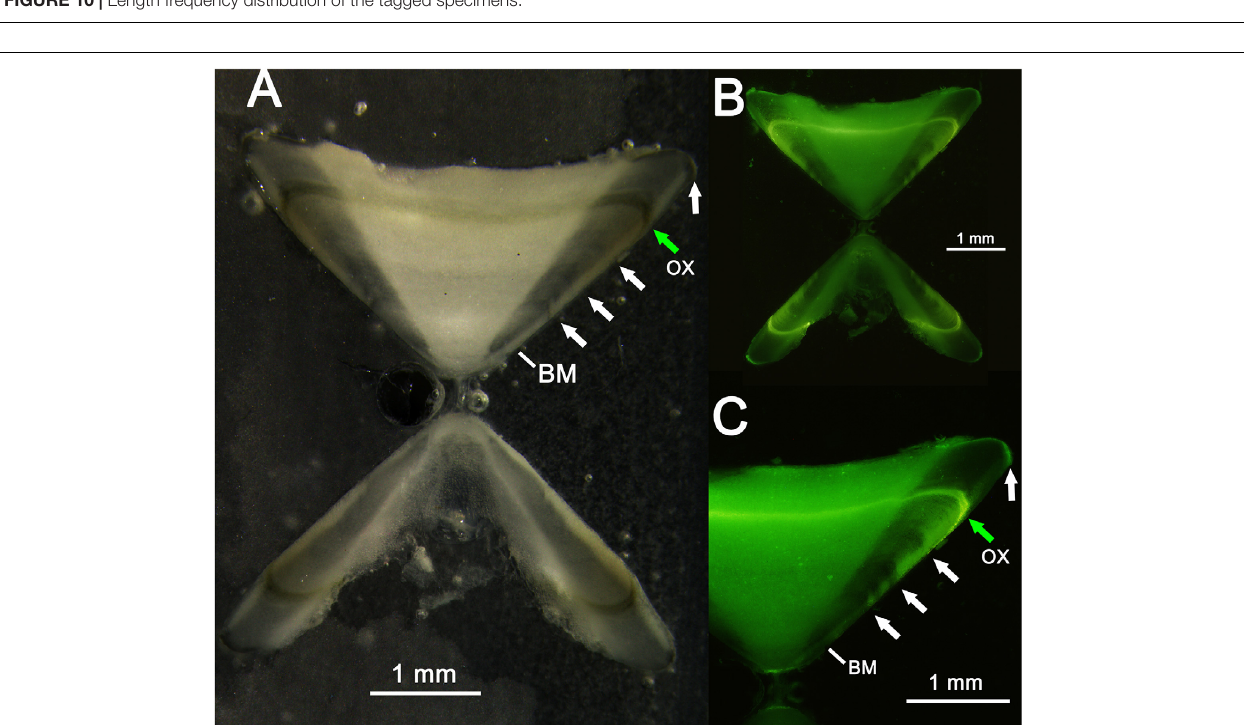
FIGURE 11 | Vertebral thin section of a recaptured thornback ray: (A) thin section observed with reflected light; (B,C) thin section observed with ultraviolet light. The transparent bands (white arrows), birthmark (BM), and oxytetracycline (OX) band (green arrow) are also indicated.